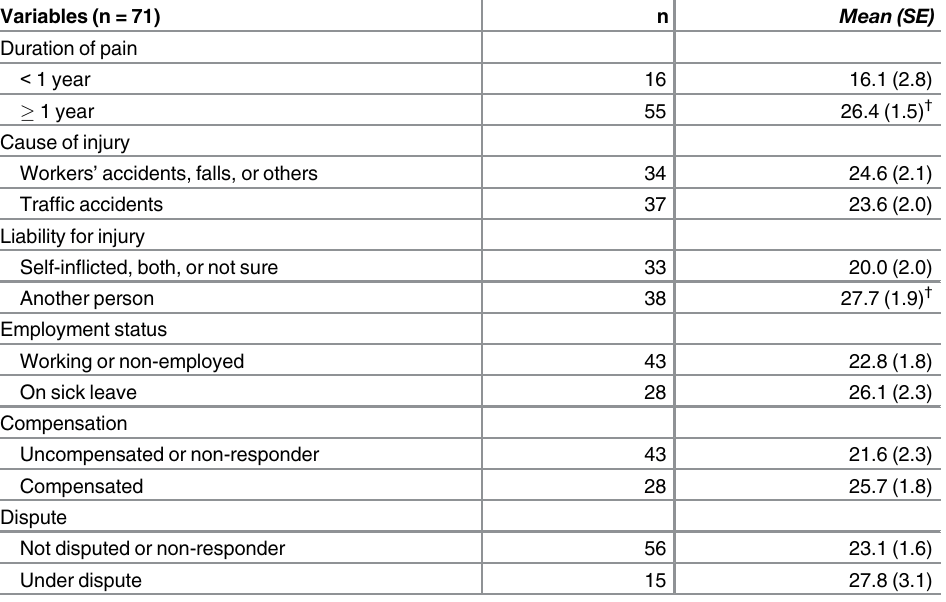
Table 7. Mean values of IEQ-J total scores according to sample